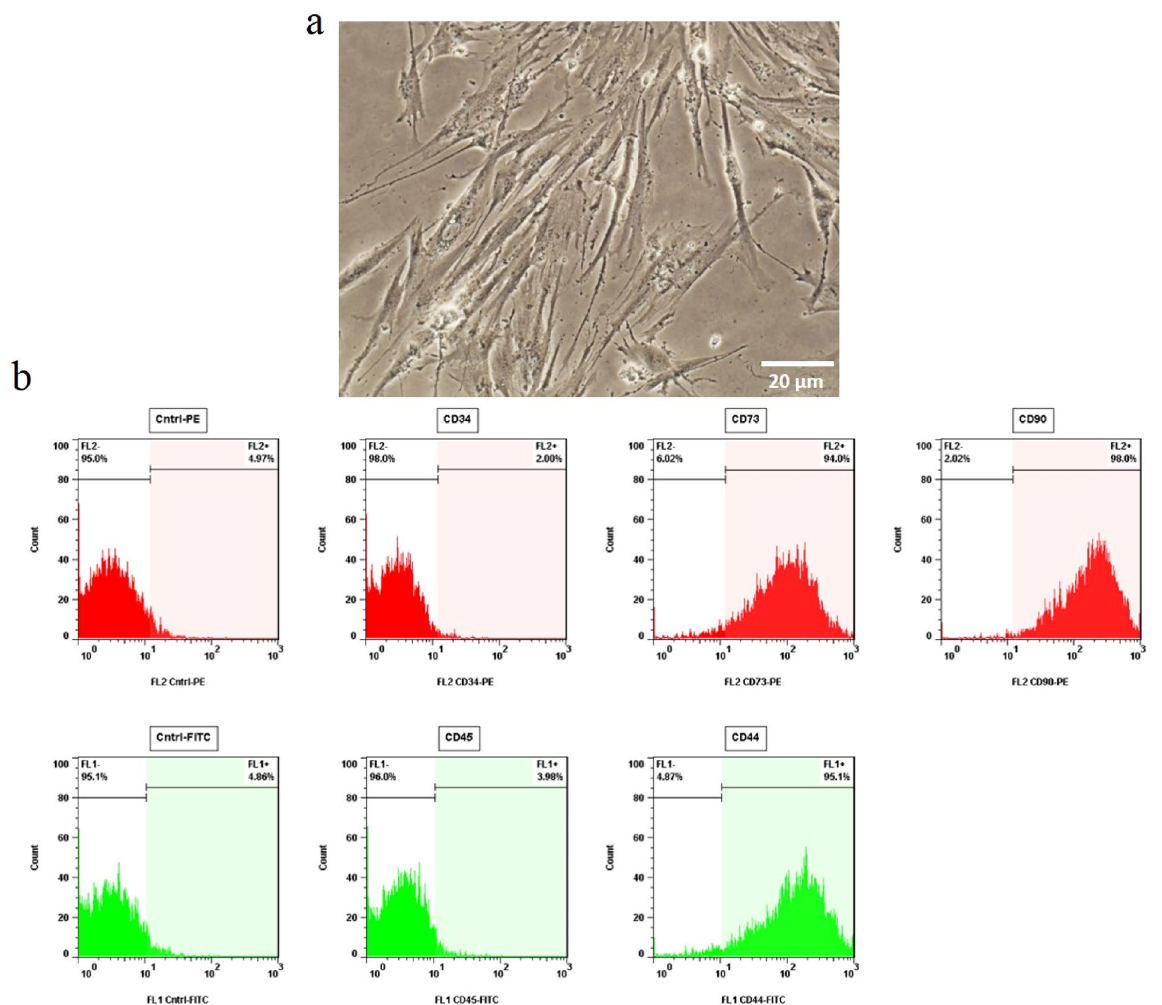
Figure 1. Characterization of human umbilical cord blood mesenchymal stem cells (UCB-MSCs). For characterization of the isolated human UCB-MSCs, cell spindle- shape morphology and the expression of a panel of positive and negative selection markers were investigated. ( a ) Mesenchymal Stem Cells with fibroblast- like morphology are shown at passage three (magnification 20X). ( b ) Representative flow cytometry histograms illustrating the typical expression of CD44, CD73, CD90 antigens by the isolated cells; while a few number of them could express hematopoietic markers such as CD34 and CD45. Positive expression was defined as the level of fluorescence greater than 95% of the one measured using the matched isotype control